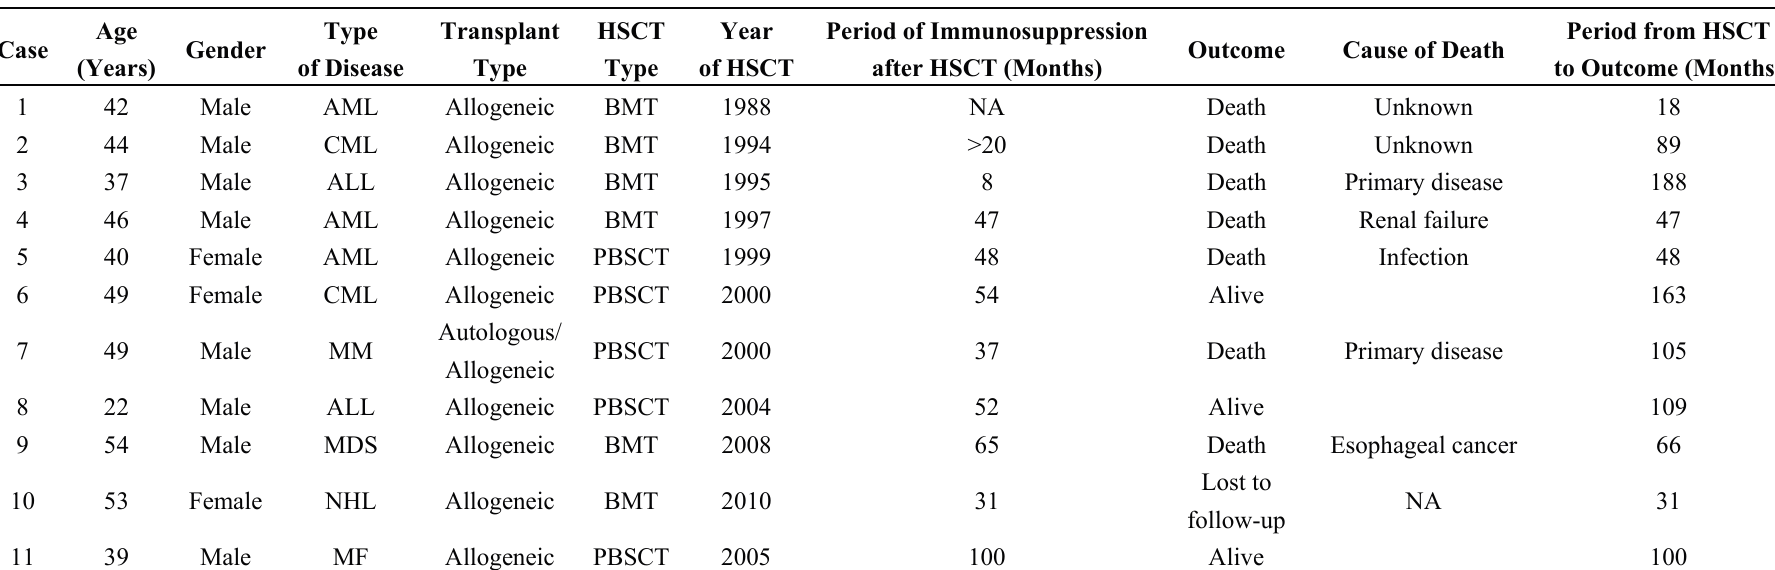
MM, multiple myeloma; MDS, myelodysplastic syndrome; NHL, non-Hodgkin lymphoma; MF, myelofibrosis; BMT, bone marrow transplantation; PBSCT, peripheral blood stem cell